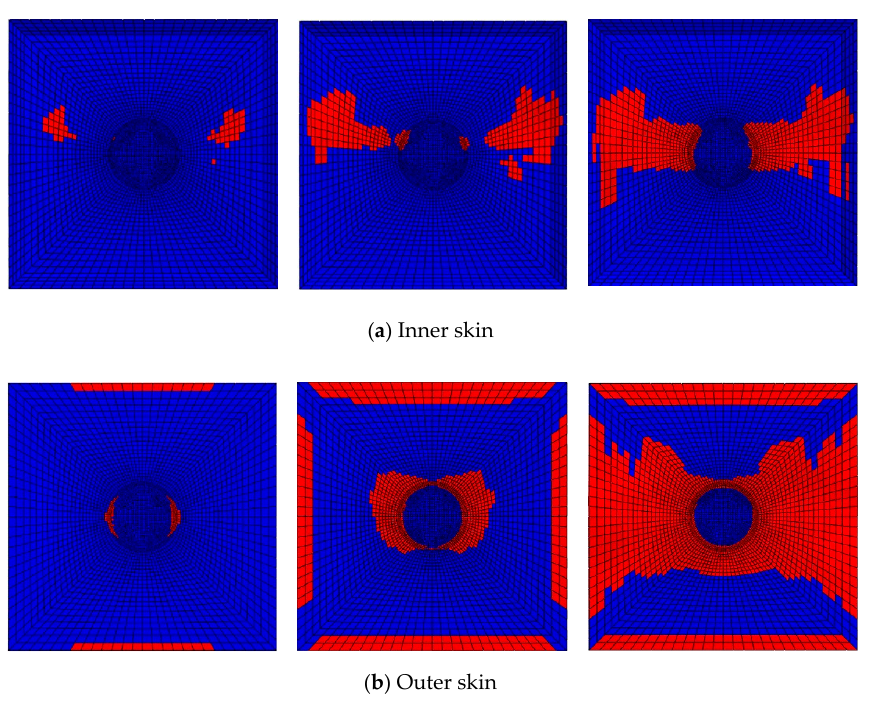
Figure 18. Honeycomb damage propagation in the CD80 Model. ( a ) the damage propagation of inner skin; ( b ) the damage propagation of outer skin.